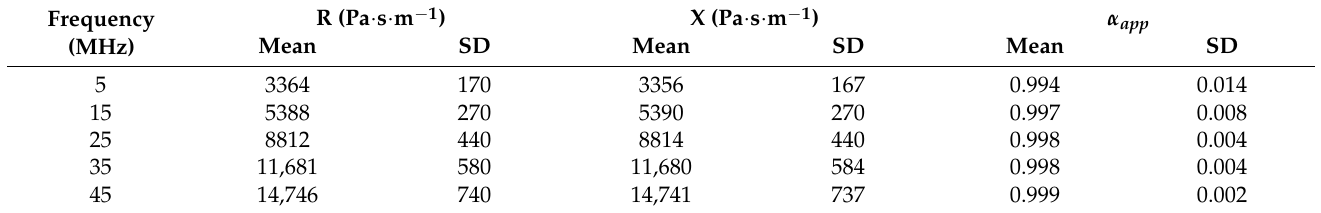
Table 4. Statistical mean and standard deviation (SD) values of measured mechanical impedance for BEM loading. The values are averaged over 18